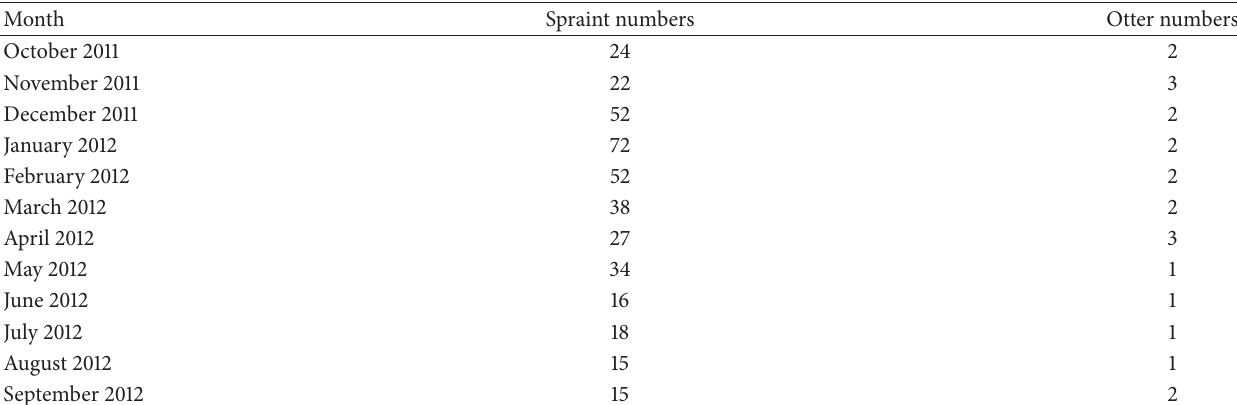
Table 1: Spraint numbers and otter numbers by month at Loch na Dal.